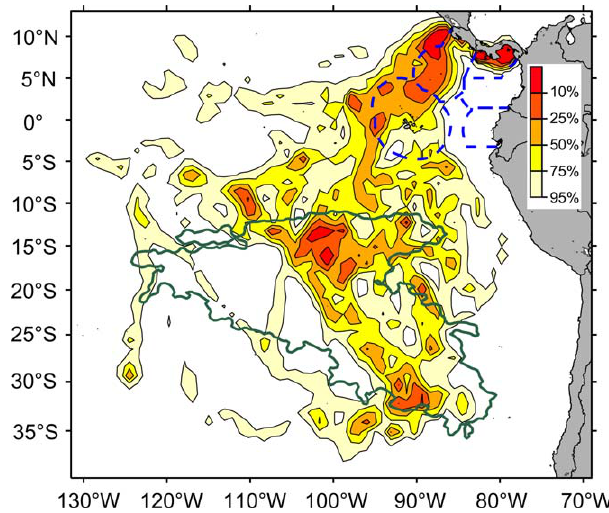
Figure 4. Combined Utilization Distribution by EP Leatherback Turtles from all Tracking Data EP leatherback turtle home-range utilization distribution for all years combined (2004, 2005, and 2007). Boundaries of the ETPS, corresponding to the exclusive economic zones of Costa Rica, Panama, Ecuador, and Colombia, are shown as dashed blue lines. The green polygon comprises the region with the lowest climatological EKE ( (cid:3) 30 cm 2 s (cid:2) 2 ) in the South Pacific